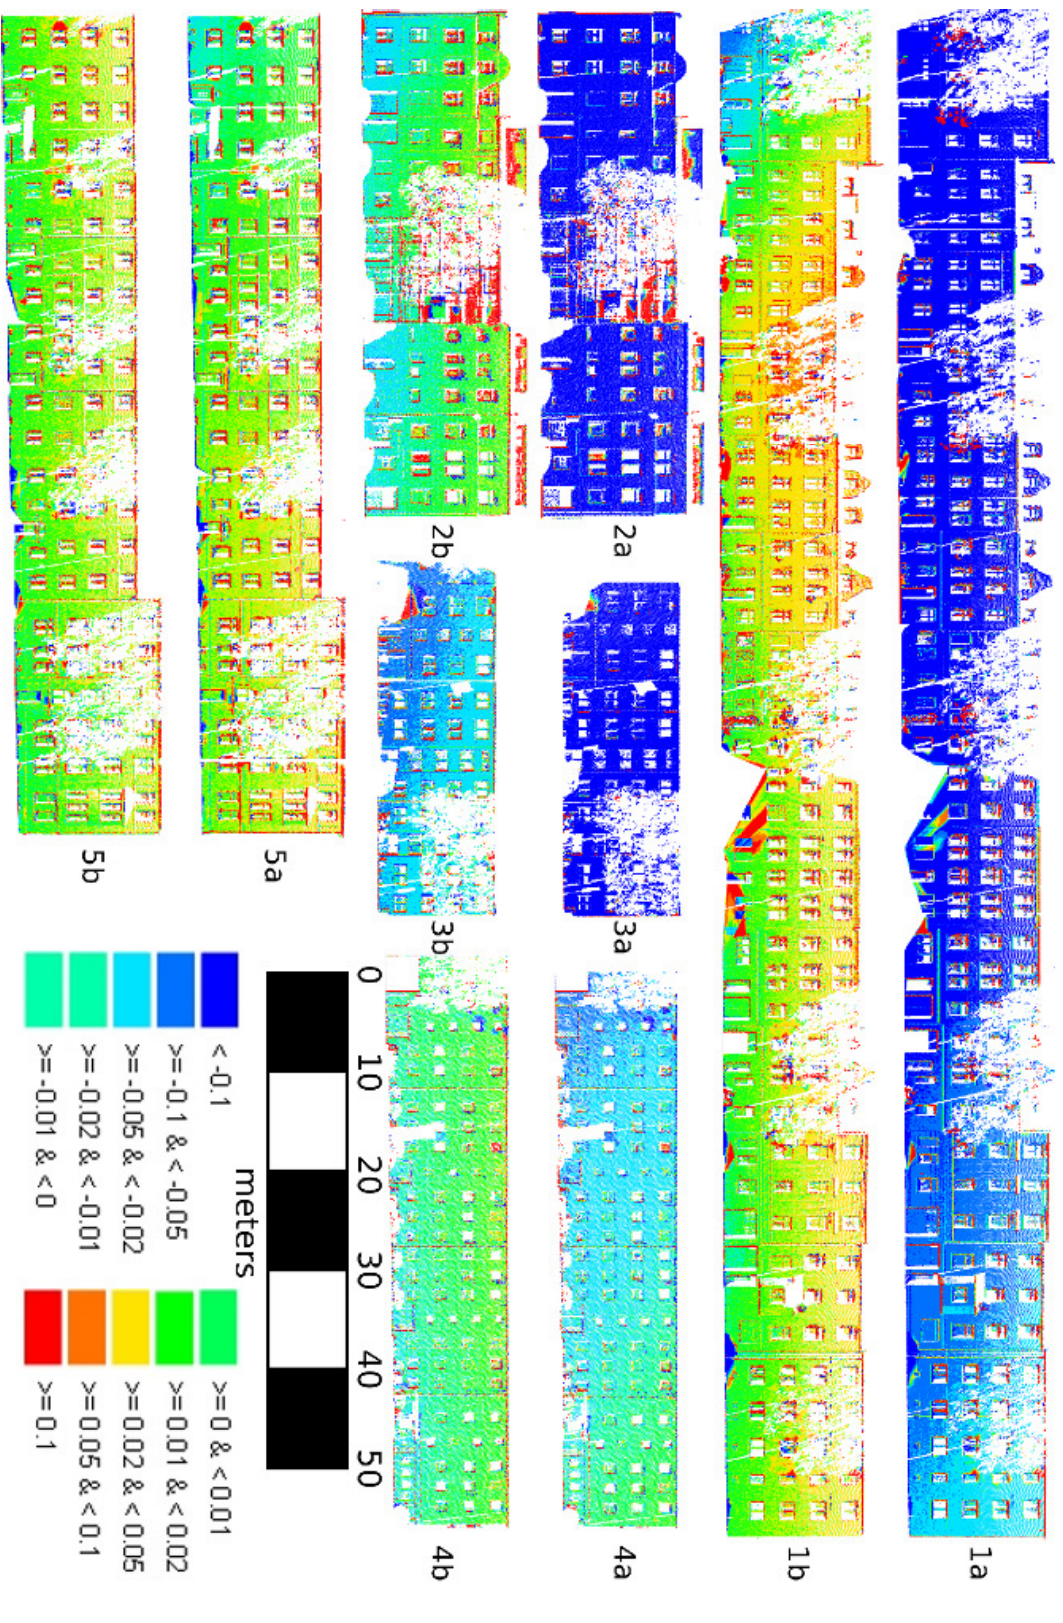
Figure 20. Facade deviations in the Dortmund 2 dataset. Refer to the legend in the bottom for deviation in meters (m). Facades marked with “a” are those in the original Lynx Mobile Mapper data. Facades marked “b” show the deviations after semi-rigid